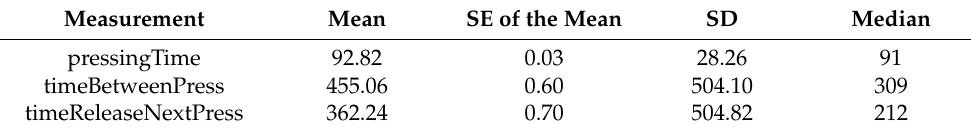
Table 1. Descriptive statistics of measurements for the transformed dataset ( n = 712,418).